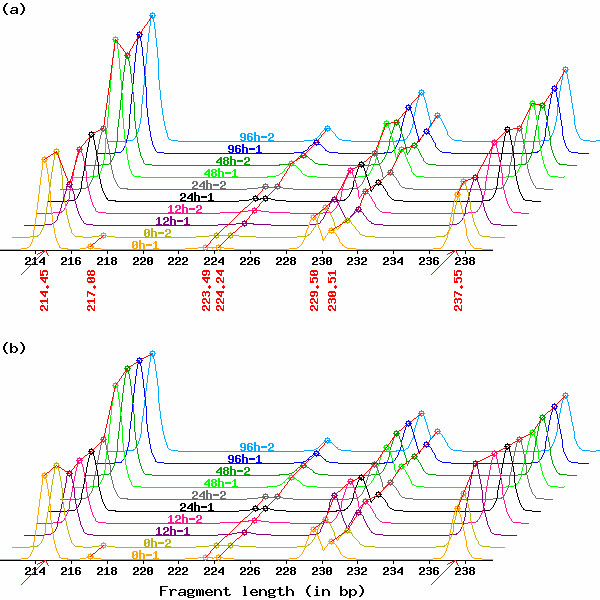
Effect of peak height normalization by GOGOTnormH. Electropherograms when peak height normalizations are performed using (a) all the reported TDFs (a conventional method used in [12, 28]) and (b) a subset of the selected TDFs (GOGOTnormH).